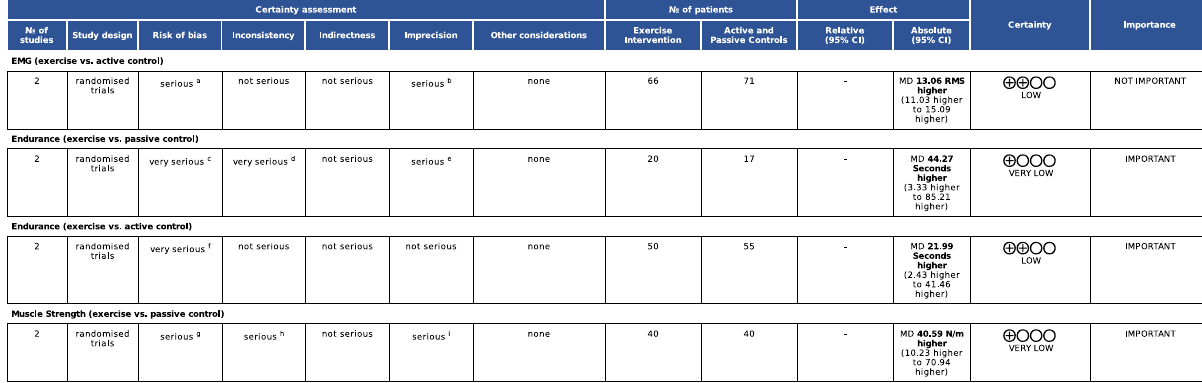
Figure 6. GRADE analysis. CI confidence interval; MD mean difference. Explanations: a = The study of Mannion et al. presented a Pedro score of 5/10 (low quality). b = Small effect (8.7%) requires a total sample size of approximately 400 (200 per group). c = The studies were classified as low quality (score 3/10 = Cortell-Tormo et al. 72 ; score 4/10 = Kell et al. 51 ). d = The heterogeneity between studies were substantial (I2 = 73%; p = 0.05). e = The confidence interval are very large (3.33–85.21 s). f = The studies were classified as low quality (score 5/10 = Mannion et al. 46 ; score 4/10 = Kell et al. 51 ). g = Bruce-low et al. 37 . The study does not provide concealed allocation and blinded assessments (score = 5/10). h = The heterogeneity between studies were reported by I2 statistics as 58% (substantial heterogeneity). i = The analysis performed are possible underpowered considering the Optimal Information Size (OIS) required for small clinical relevance (8.5%; under 10%). In this situation the OIS estimated are about 400 participants (200 per